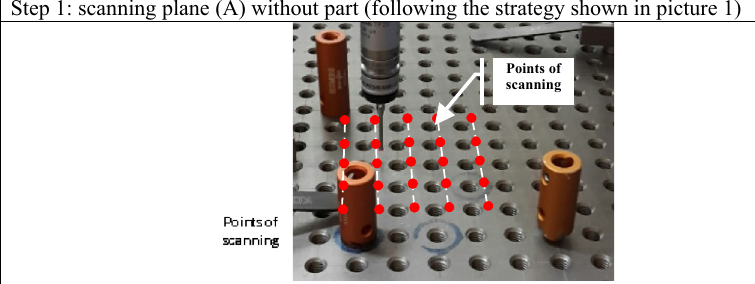
Picture 1: points of scanning used to measure plane (A). Step 2 = mounting the part and scanning machined plane (following the strategy shown in picture 2)